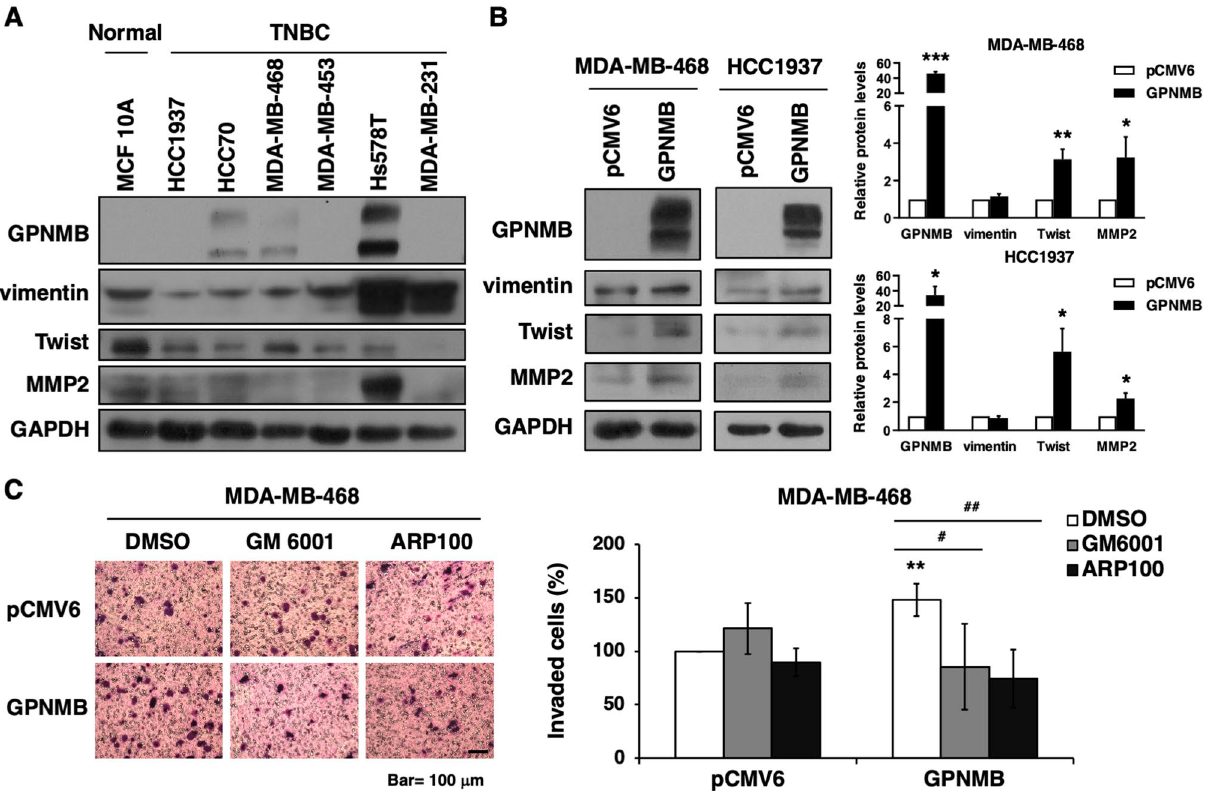
Figure 4. GPNMB drives cell invasion through MMP2. ( A ) Whole-cell extracts of MCF 10A epithelial cells and TNBC cell lines were examined by Western blot analysis. ( B ) MDA-MB-468 and HCC1937 cells transfected with GPNMB expression construct or control plasmids (pCMV6) for 48 h were analyzed by Western blot analysis (left). The Western blottings were quantified (right). ( C ) MDA-MB-468 cells were transfected with GPNMB-expressing or pCMV6 plasmids for 48 h. The transfected cells were resuspended in DMEM serum free medium containing DMSO, GM 6001 (20 μM) or ARP100 (20 μM) for invasion assay. Data are representative of three independent experiments. * P < 0.05, ** P < 0.01, *** P < 0.001, # P < 0.05, ## P <